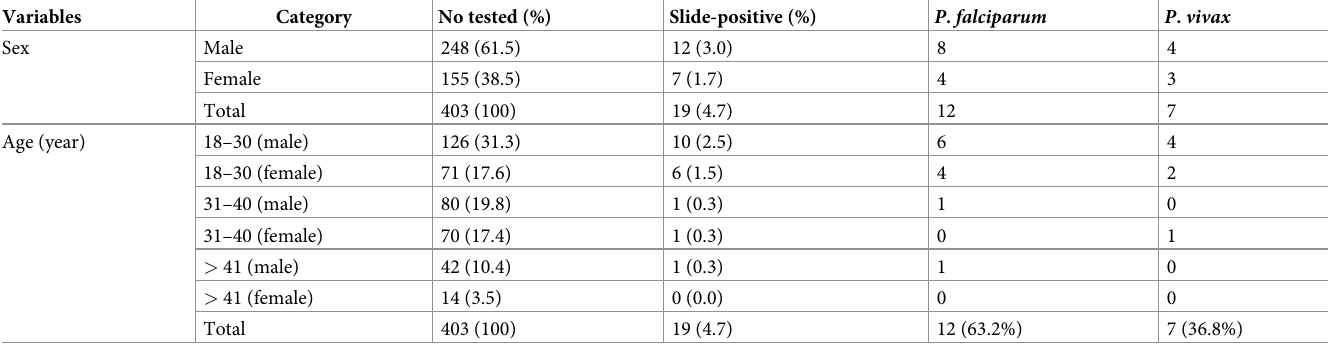
Table 2. Demographic characteristics of the respondents diagnosed for malaria at MHC ( N = 403).